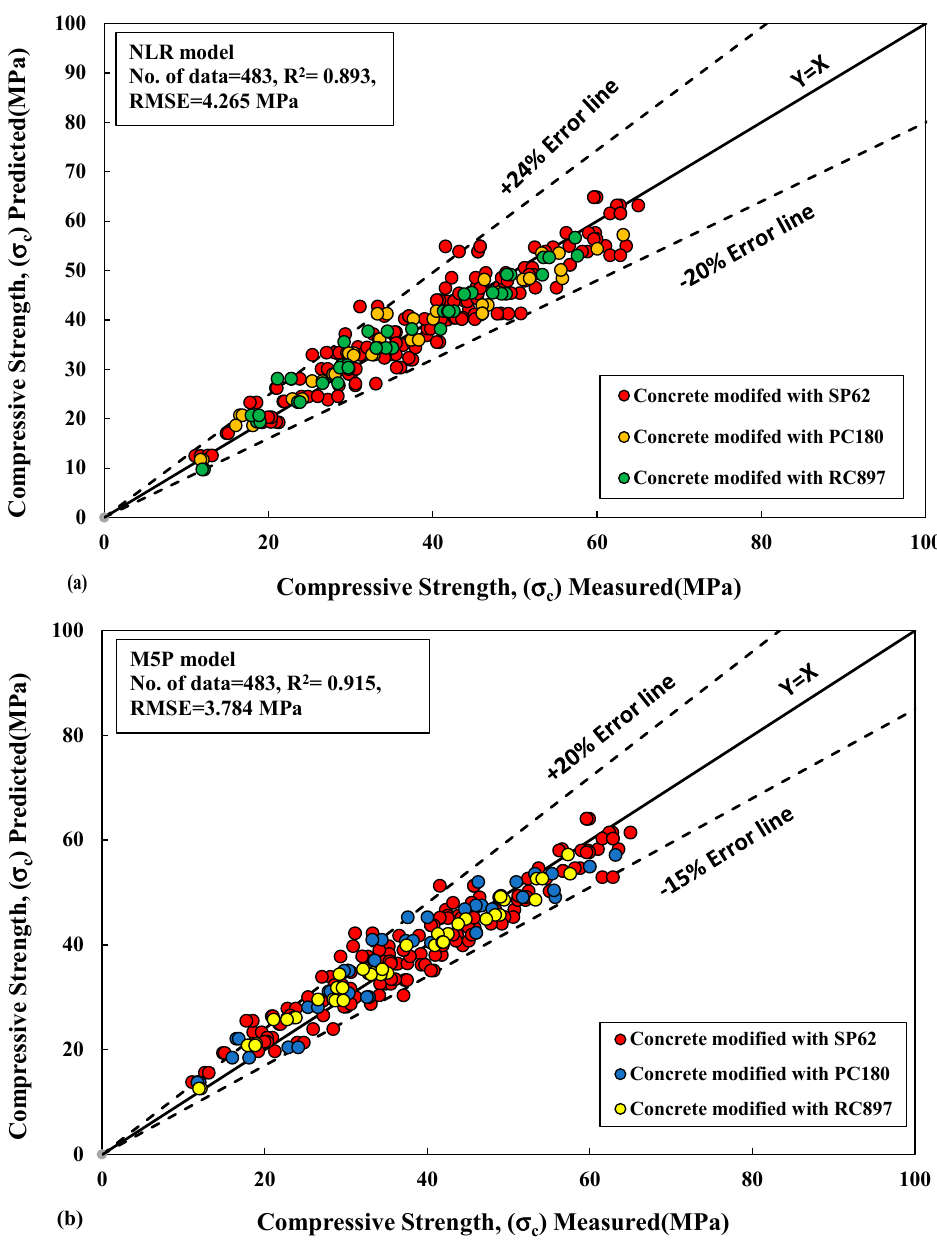
Figure 6. The mix proportions’ impact on the concrete compressive strength using ( a ) nonlinear and ( b ) M5P models.